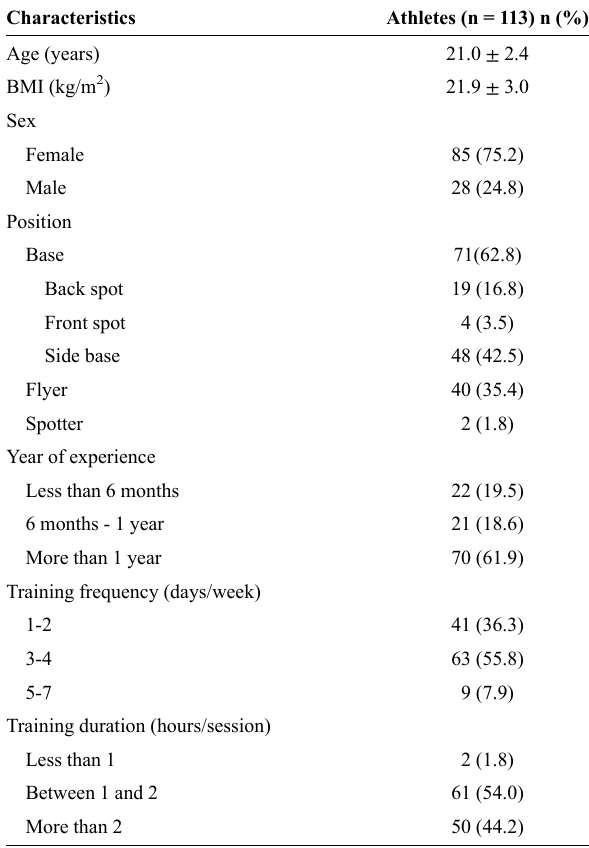
Table 1 - Descriptive data for cheerleading participation.